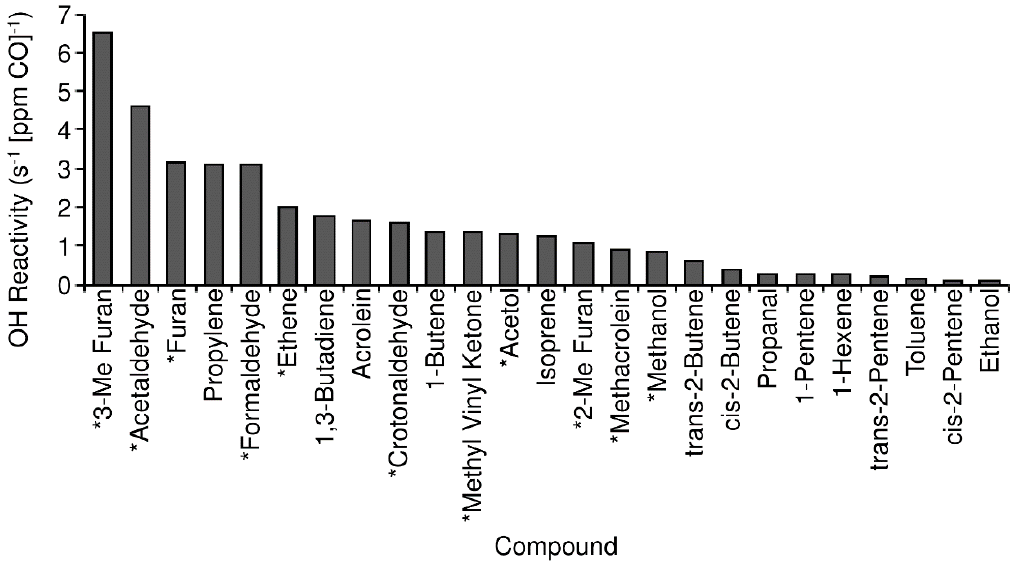
Figure 5. OH reactivity of 25 highest reactivity VOCs measured or estimated in this study. Compounds marked with a * are estimated from the “Pasture Maintenance” category [41] .